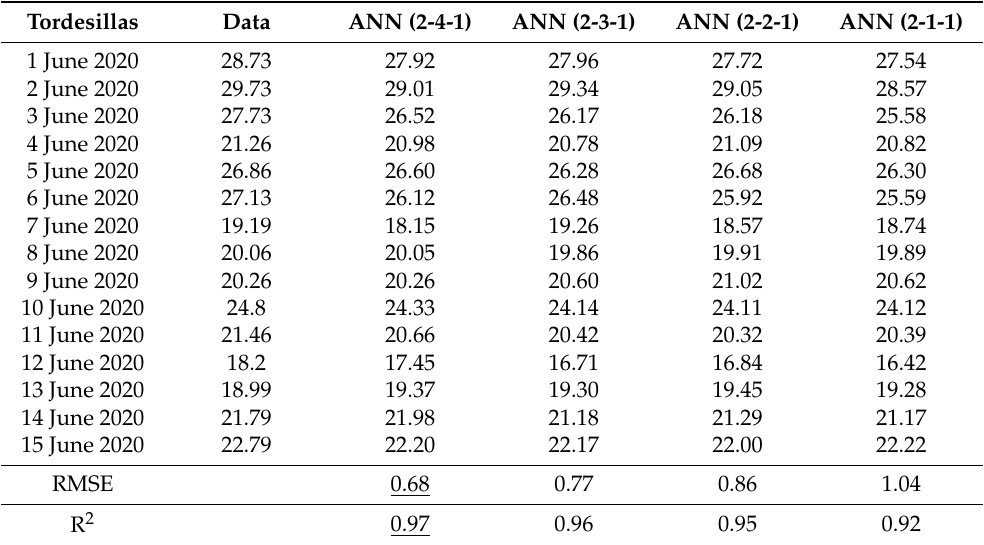
Table 2. Daily maximum temperature ( ◦ C) in Tordesillas (Valladolid) measured for 15 days (i.e., 1–15 June 2020), estimation performed with the neural architectures varying the number of neurons from four to one in the hidden layer (i.e., ANN (2-4-1), ANN (2-3-1), ANN (2-2-1) and ANN (2-1-1)), and fitting of the statistics.